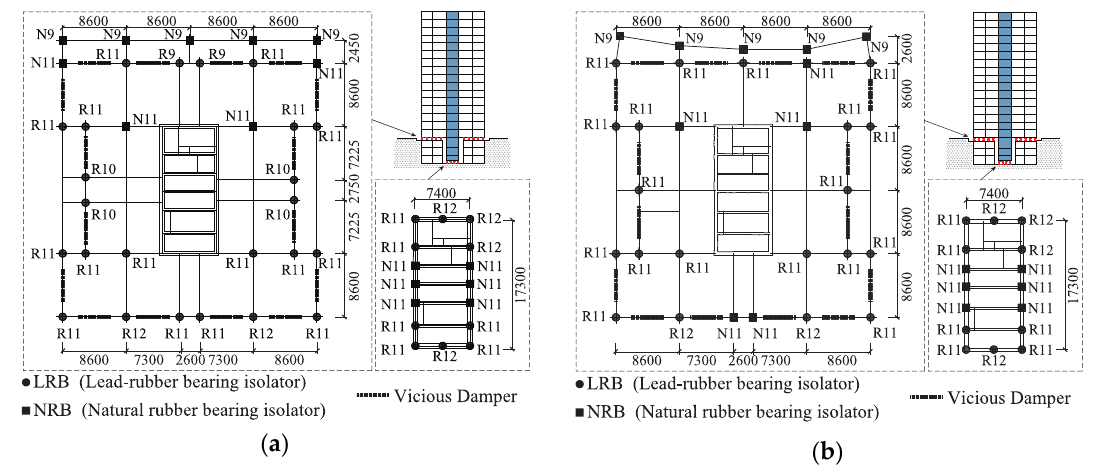
Figure 2. Isolation system of prototype reinforced concrete (RC) frame-core tube tall buildings: ( a ) C1 and ( b ) C4. Table 1. Characteristic parameters of the isolators.